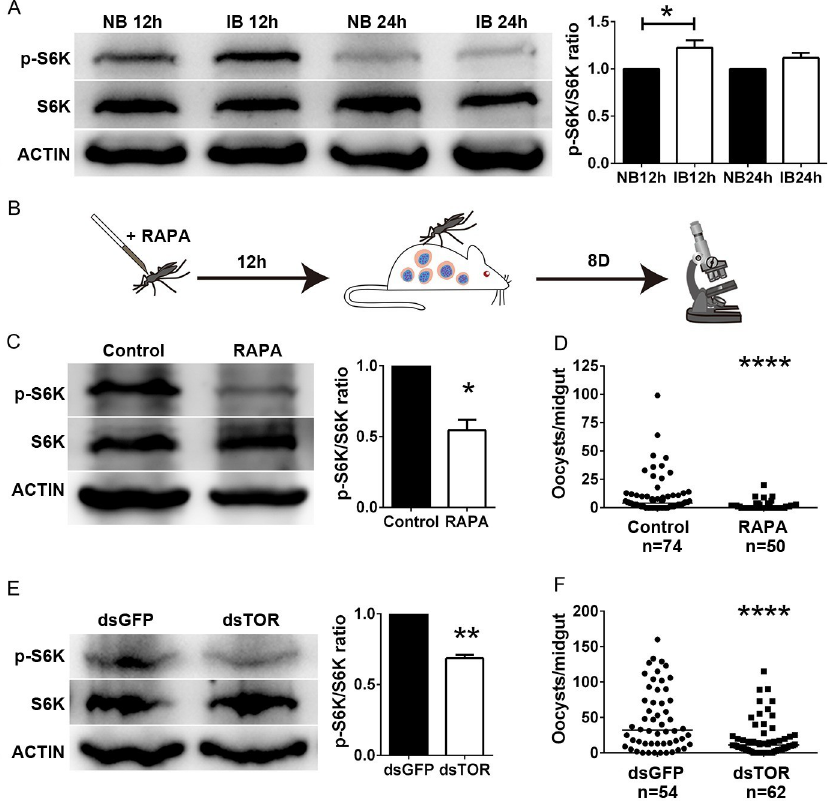
Fig 1. Inhibition of the TOR pathway decreases P . berghei infection. (A) Influence of P . berghei infection on the TOR pathway by Western blot analysis. Phosphorylation levels of S6K from fat bodies 12 h and 24 h post-normal (NB) and infectious blood meal (IB) were analyzed using anti-Phospho-S6K antibody. An . stephensi S6K and ACTIN were used as internal controls (left panel). The intensity of phosphorylated S6K was normalized to that of S6K. The relative intensity of phosphorylated S6K in IB-fed mosquitoes was normalized to that of NB-fed mosquitoes (right panel). Results were pooled from three independent experiments. (B) Schematic overview of rapamycin microinjection of An . stephensi . Vehicle solution was injected as a control. (C) The influence of rapamycin treatment on the mosquito TOR pathway. Phosphorylation levels of S6K from fat bodies 24 h post-blood meal were analyzed. Quantification of p-S6K signal intensity in rapamycin-treated mosquitoes was normalized to that of controls. The results are from two independent experiments. (D) Influence of rapamycin treatment on Plasmodium infection. Data were pooled from three independent replicates. (E) Influence of TOR knockdown on the activity of the TOR signaling pathway. Relative quantification of p-S6K signal intensity was from two independent replicates. (F) Influence of TOR knockdown on Plasmodium infection. The data were pooled from three independent biological experiments. Horizontal black bars indicate median oocyst numbers. Each dot represents an individual mosquito. Error bars indicate standard errors. Significance was determined by Student’s t- test in (A), (C), and (E) and by Mann-Whitney tests in (D) and (F); � P < 0.05, �� P < 0.01, ���� P < 0.0001. development [17, 18], it is highly possible that rapamycin limits Plasmodium infection via inhibition of the mosquito TOR signaling pathway. To address this specifically, we knocked down TOR mRNA using a double-stranded (ds) RNA-mediated RNA interference (RNAi) strategy. The dsRNA treatment (dsTOR) led to a 44.5% reduction of TOR gene expression and a significant decrease in the protein level of phosphorylated S6K compared to that of the dsGFP controls (Figs S1 and 1E). Similarly, depletion of TOR by RNAi resulted in a signifi- cant reduction of the oocyst number, from 32 in dsGFP to 11 in dsTOR (Fig 1F). Altogether, these data suggest that inhibition of the TOR signaling pathway protects An . stephensi from Plasmodium infection.